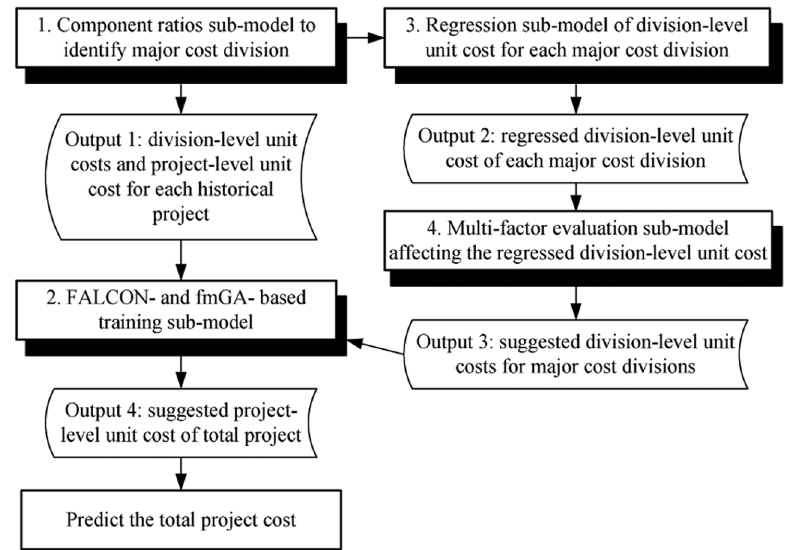
Fig. 1. Framework of the proposed